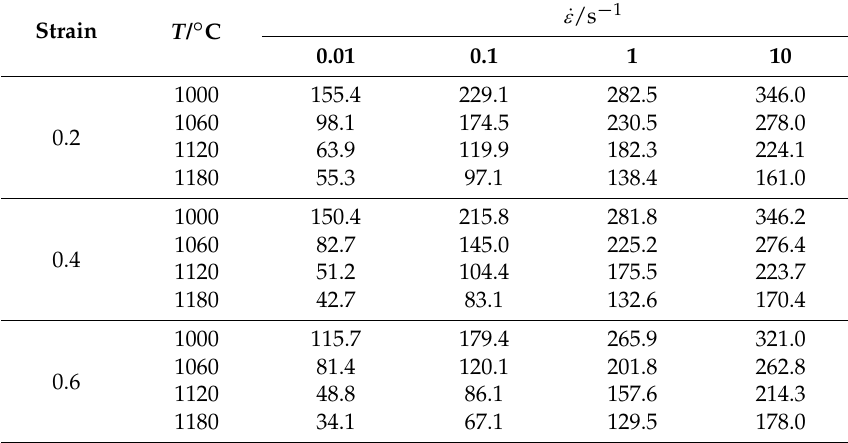
The correlation between experimental stress and predicted stress (calculated stress) of peak stress is shown in Figure 7. The data in Table 4 were calculated by using Equation (18), and then the average relative error and the correlation coefficient were obtained: AARE = 5.9463%; RR = 0.99343. This indicates that the peak stress constitutive equation established in this paper can well describe the flow stress relationship of 21-4N heat-resistant steel at different temperatures and strain rates.